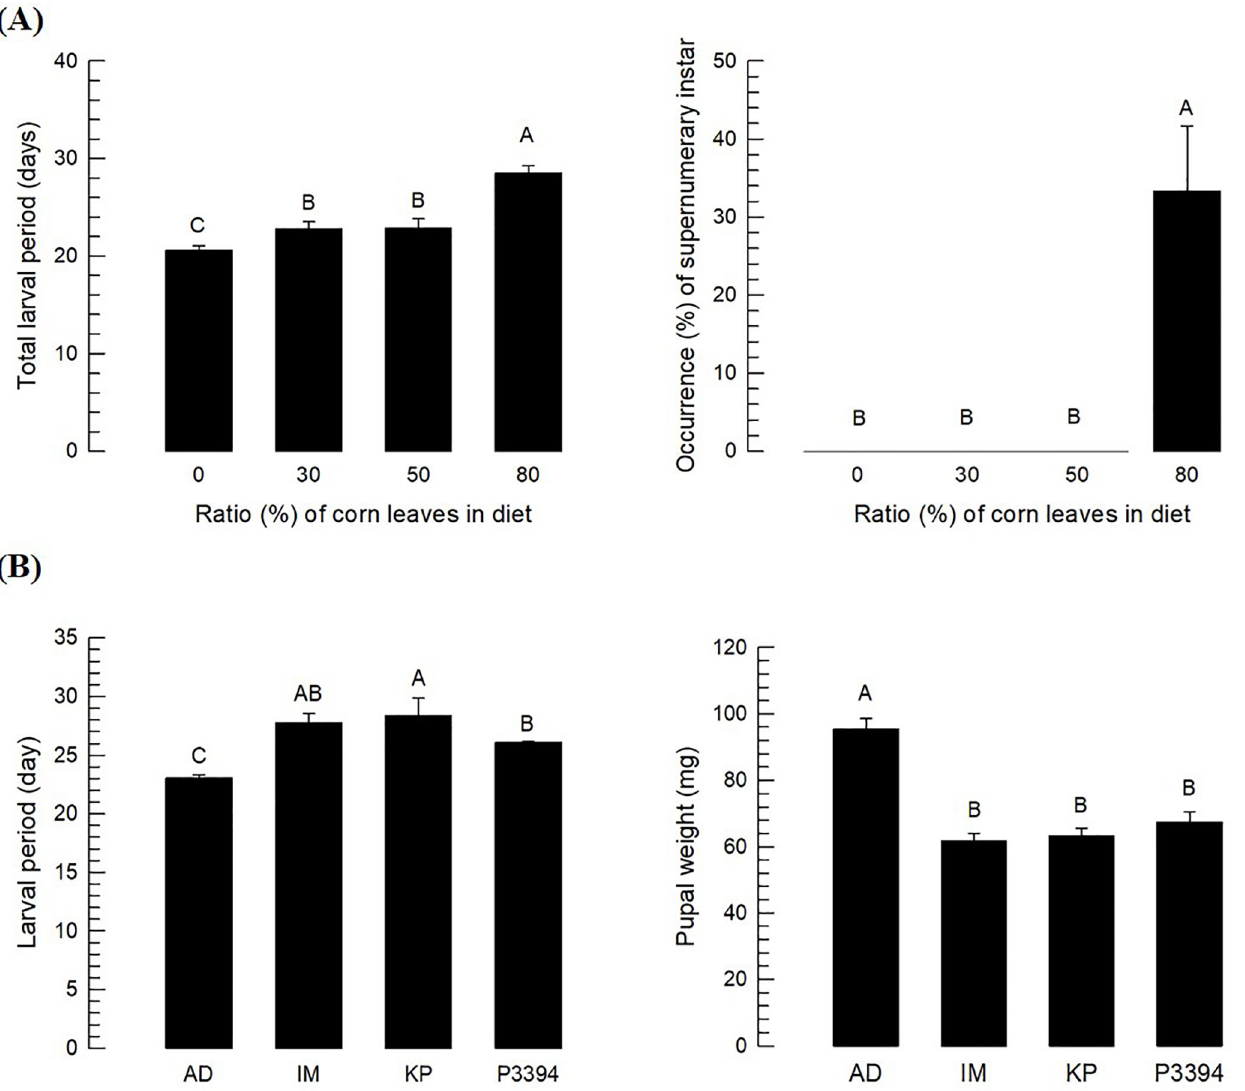
Fig 2. Influence of resistant corn varieties (Ilmichal (‘IM’), Kwangpyeongok (‘KP’) and P3394) on O . furnacalis development by adding to artificial diet. (A) Effects of KP variety at different doses by adding the freeze-fried leaf powder to artificial diet on larval developmental rate and production of supernumary instar. Newly hatched larvae were reared with different diets. Each treatment was replicated three times. Four larvae were used in each replication. (B) Comparative analysis of three resistant corn varieties on O . furnacalis development. Freeze-dried leaf powder of each variety was added to the artificial diet at 80%. Each treatment was replicated three times. Ten larvae were used in each replication. Different letters above standard error bars indicate significant difference among means at Type I error = 0.05 (Tukey test).